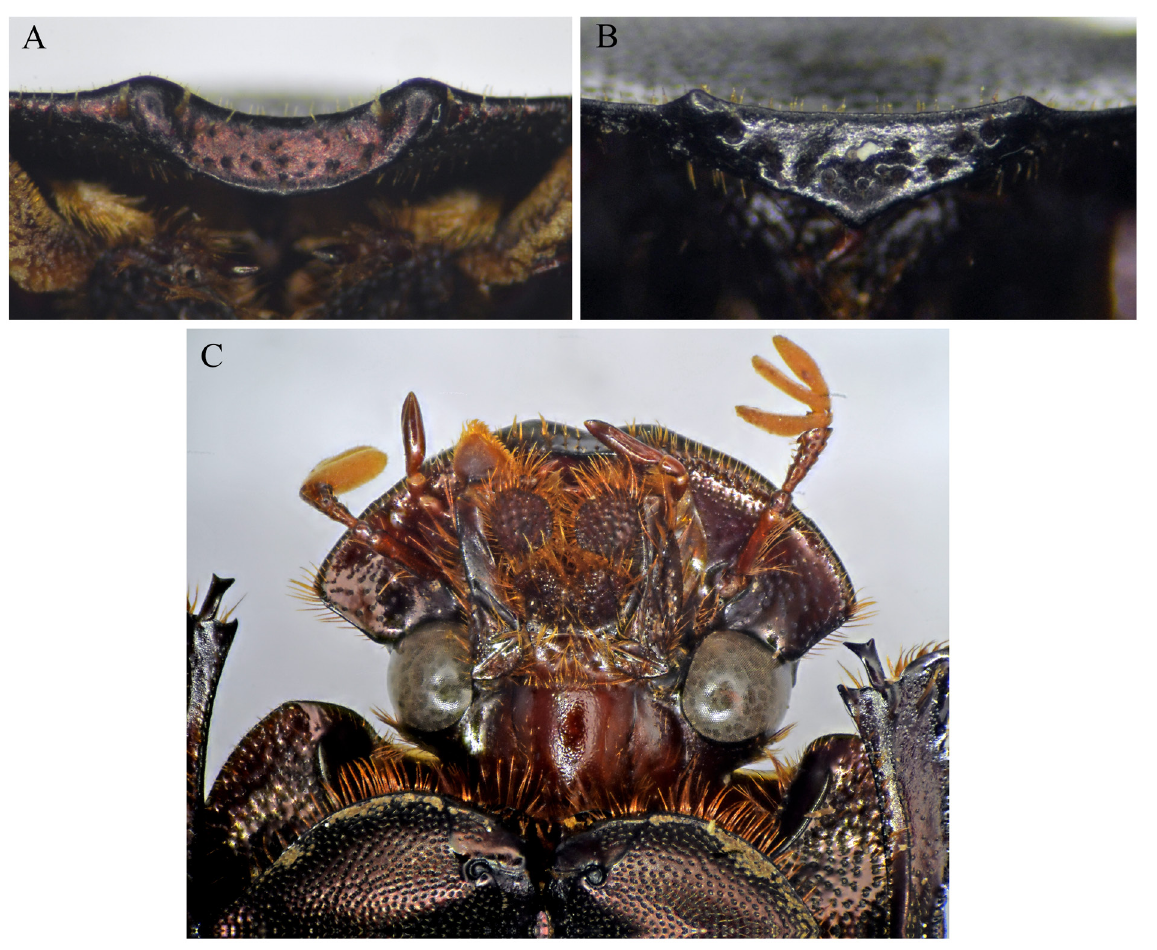
Fig. 6. Head. A‒B . Clypeal process. A . Streblopus opatroides van Lansberge, 1874. B . S. punctatus (Balthasar, 1938). C . Ventral view of head, S. opatroides